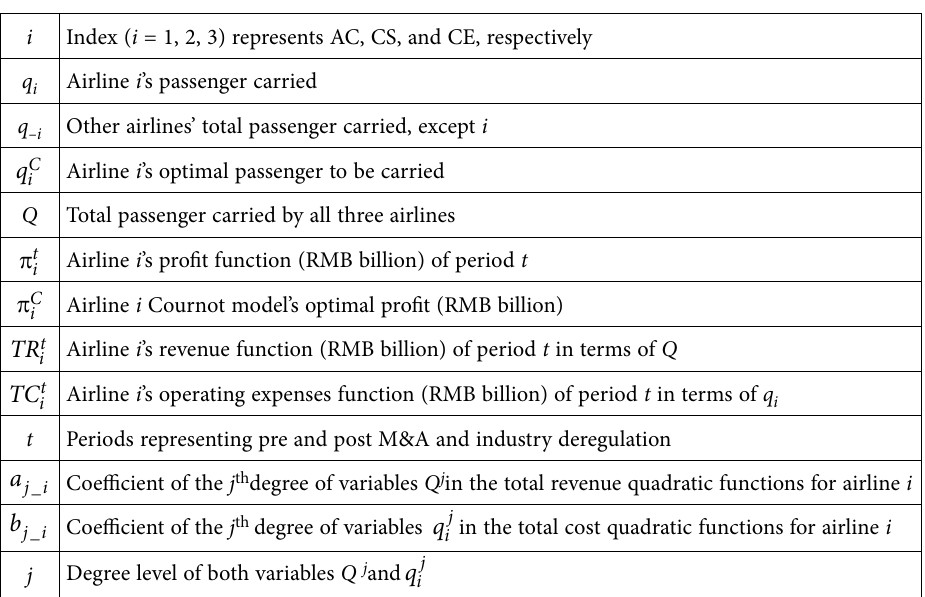
Table 2 shows the outline of the notations used in this paper. Table 2. List of mathematical symbols and